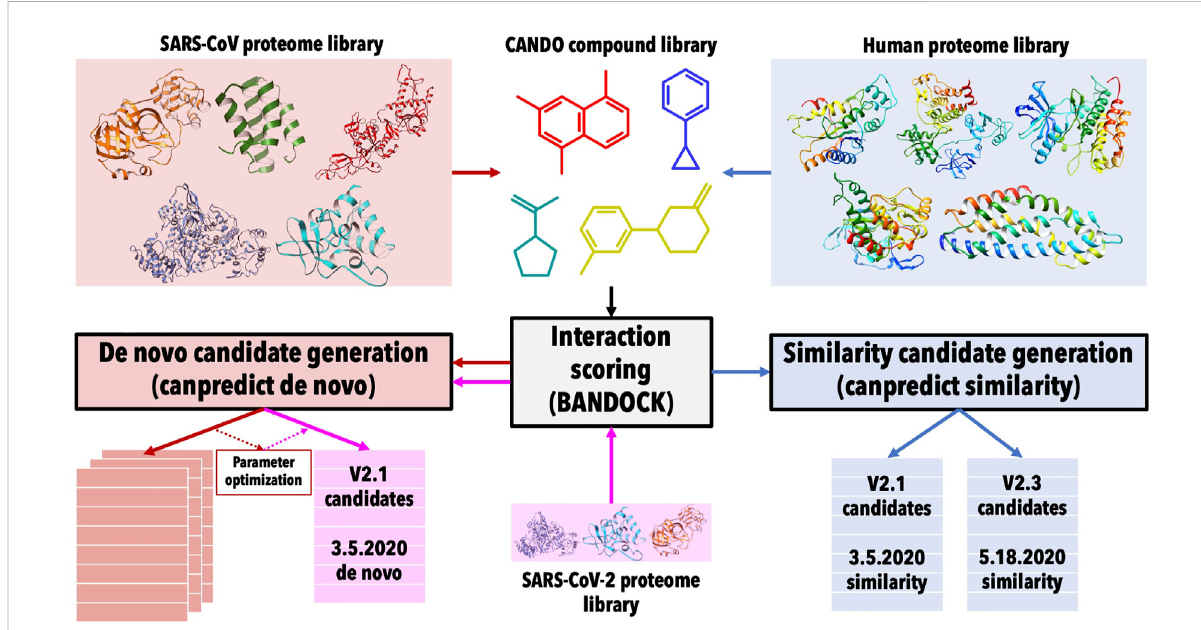
FIGURE 1 OverviewofCOVID-19drugcandidatepredictionpipelineswithintheCANDOplatform.Drug/compoundstructurelibrarieswerecuratedfrom DrugBank(Wishartetal.,2018)andproteinstructurelibrariescomprisingboththehumanandSARS-CoVproteomeswereextractedfromtheProtein Data Bank (Burley et al., 2019). Interaction scores between every protein and compound in the corresponding libraries were calculated using our bioanalyticdocking(BANDOCK)protocol(Mangioneetal.,2020a;Schuleretal.,2021).TheinteractionscoreswiththeSARS-CoVproteinswere used for the de novo candidate generation pipeline (red) that identi fi ed compounds with the highest binding scores to multiple viral proteins, while the interaction scores with the human proteins were used for a similarity based candidate generation pipeline (blue) that identi fi ed candidates based on the similarity of their proteomic interaction signatures to drugs/compounds known to be effective against SARS-CoV in vitro . The interaction scoring protocol parameters were optimized against SARS-CoV and then applied to modeled protein structures from the SARS-CoV-2 proteome in the de novo candidate generation pipeline to produce the 3.5.20 de novo candidate list. Two distinct signature similarity drug candidate lists were generated using the version 2.1 CANDO compound library initially followed by an enhanced v2.3 compound library denoted as 3.5.20 similarity